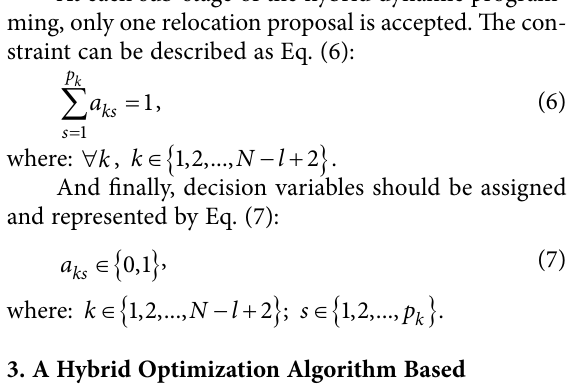
Working capacity [TEU/bay]